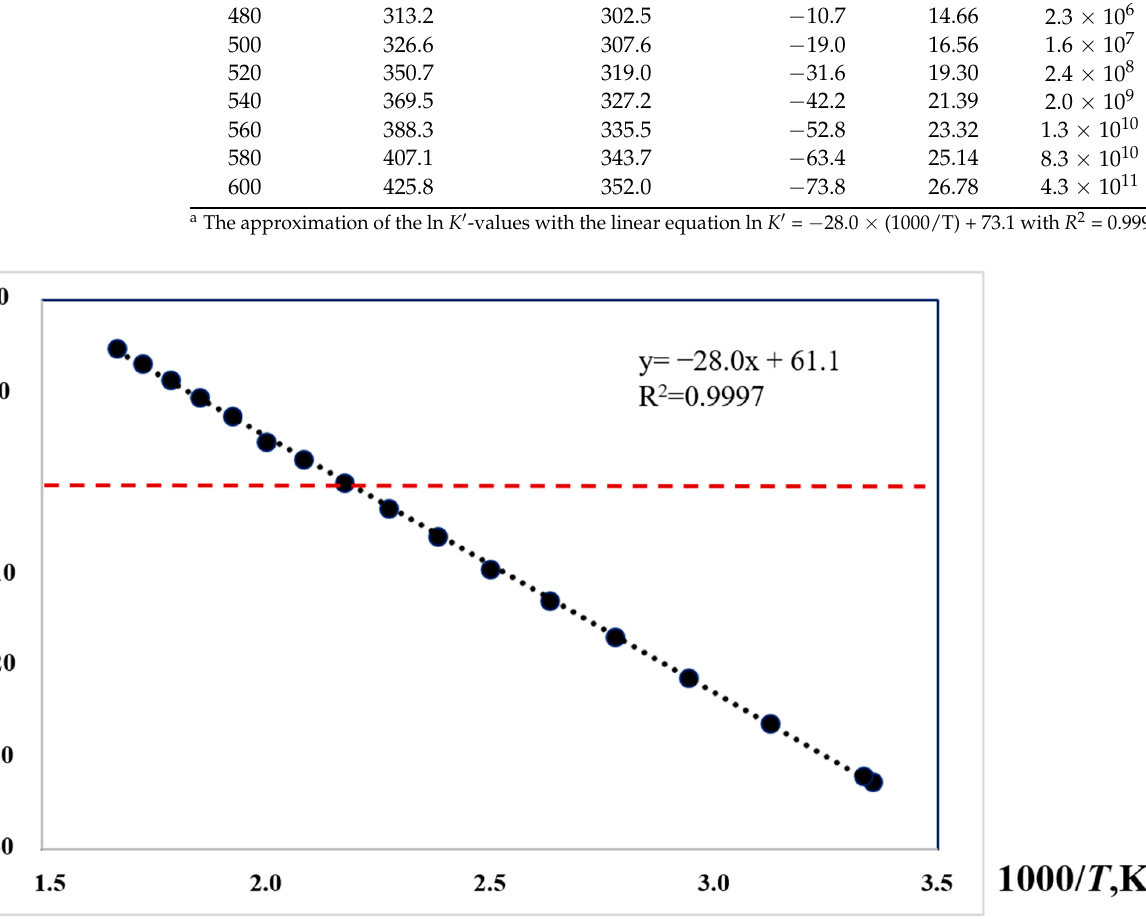
Figure 10. The ln K ´ values as a function of inverse temperature for the dehydrogenation of 2-methyl-8H-indole to 2-methyl-indole (calculated from the results in Table 13). As shown in Figure 10, values of ln K ´ greater than zero (i.e., K ´ > 1) denote the thermodynamic conditions favoring 2-methyl-8H-indole formation; values less than zero (i.e., K ´ < 1) denote reaction conditions favoring 2-methyl-indole formation. An additional